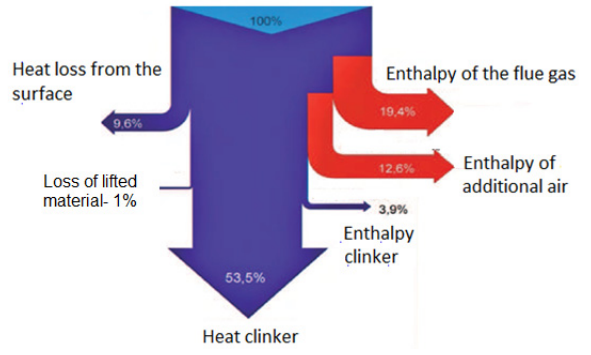
Fig. 1. Heat balance of cement kiln